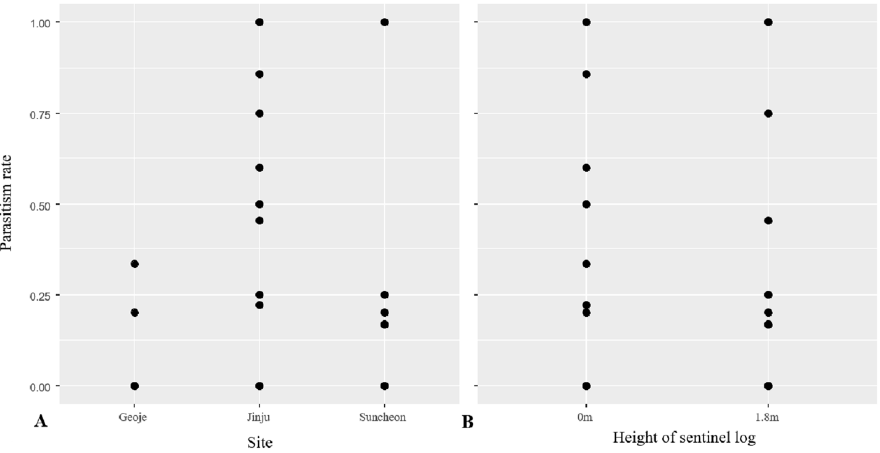
Figure 5. Scatter plot of Spathius verustus in 2016: ( A ) relationship between site and parasitism rate; ( B ) relationship between height of sentinel log and parasitism rate. Table 3. Parasitism rate analysis of Spathius verustus by ecological variables using GLMM in 2016 and 2017.